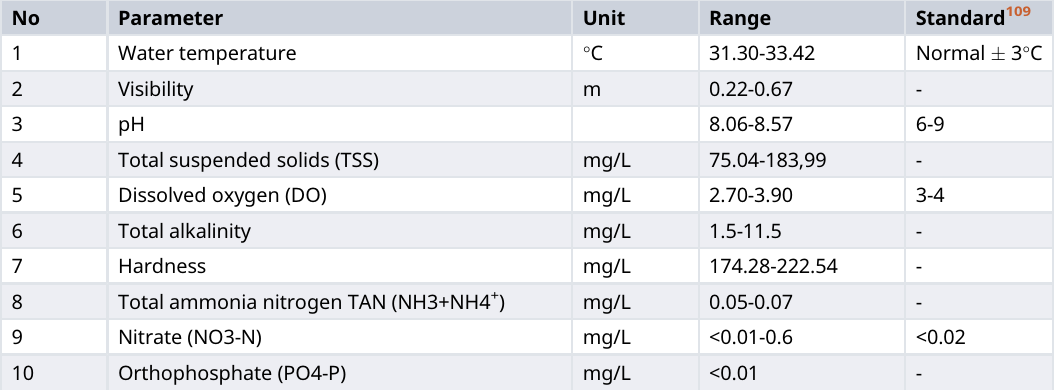
Table 5. Water quality data for Bolano Sau Lake (August-December